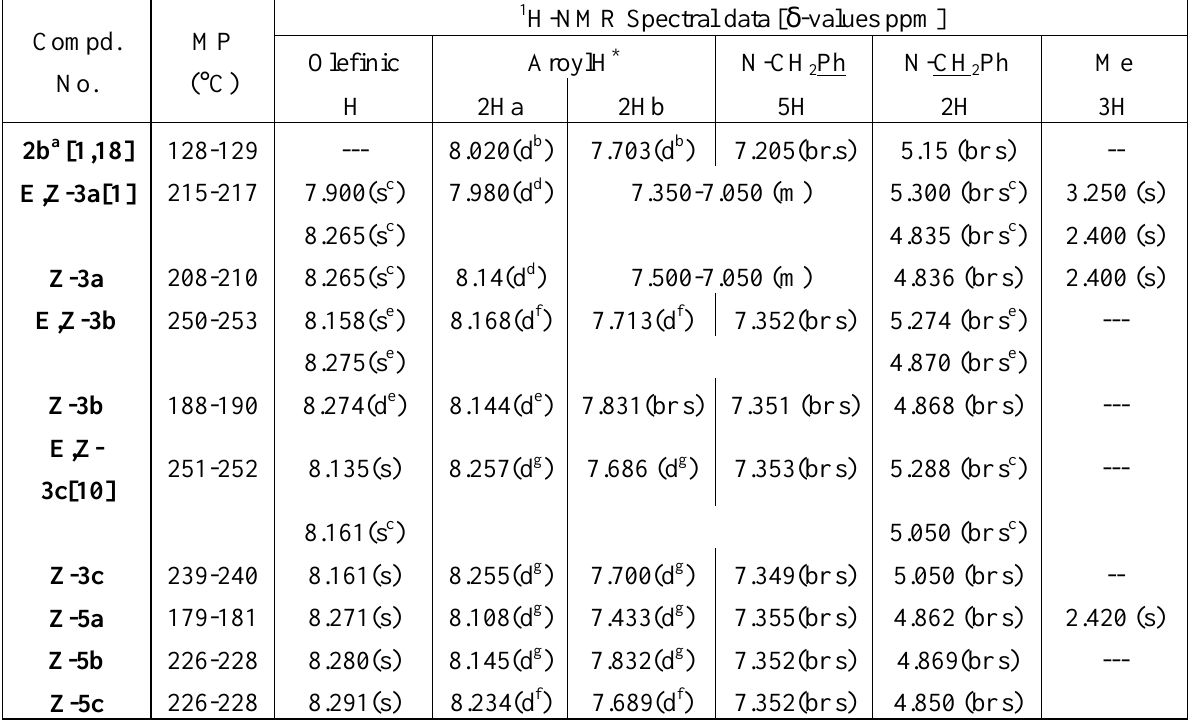
Table 2: Some Data of the Newly Synthesised